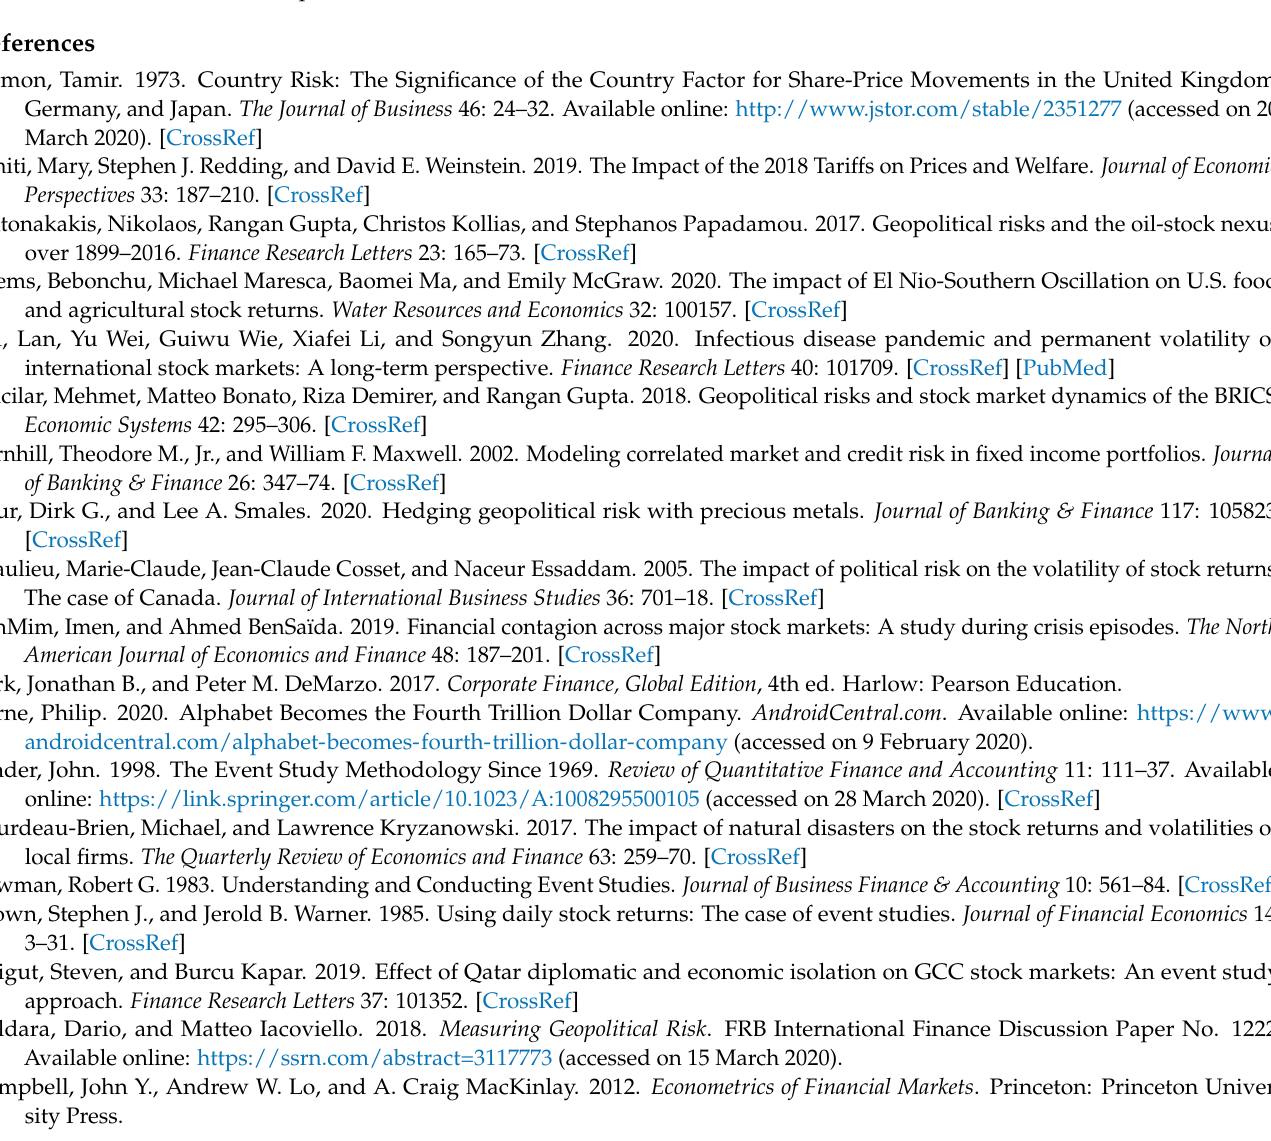
Figure A4. Summary of events with statistically significant CAARs for the Information Technology, Communication Services, and Consumer Staples sectors.